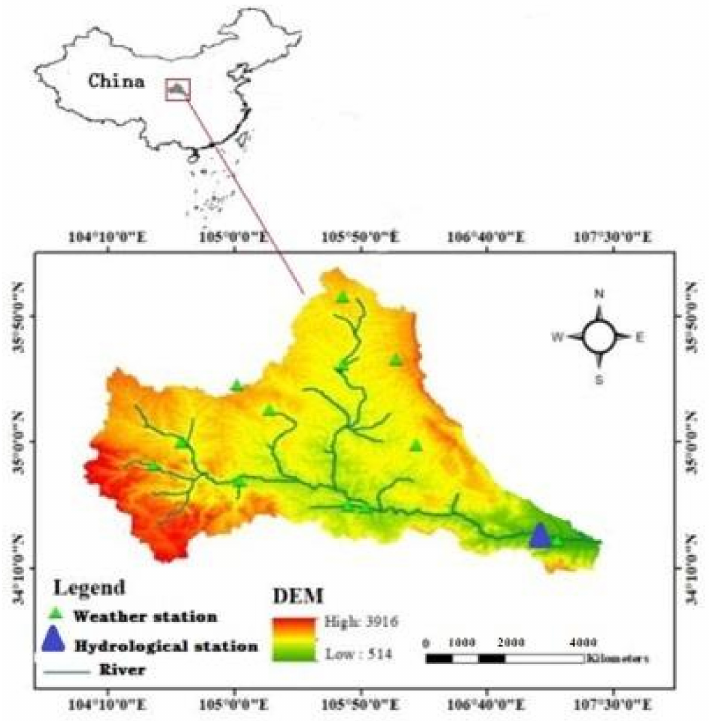
Figure 1. Location of the study